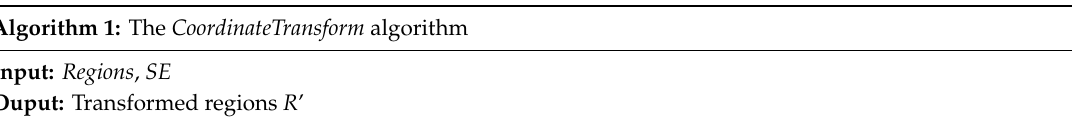
local and global regions R global .